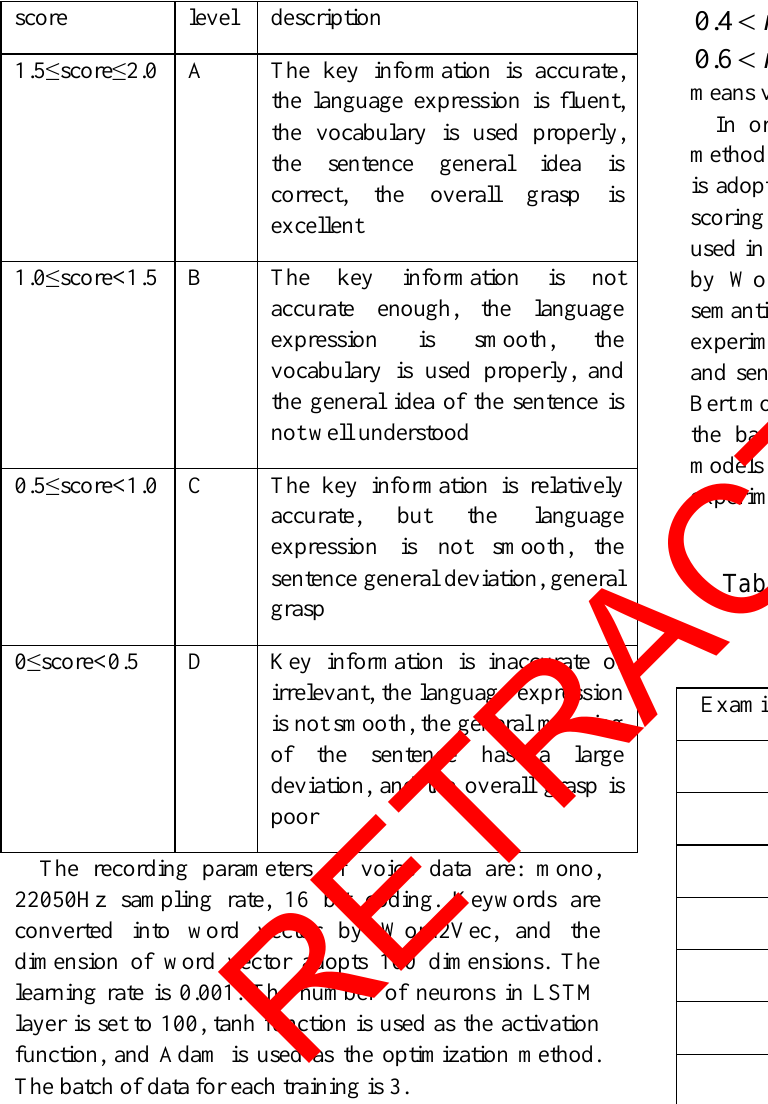
Table 2. Grading criteria and ratings